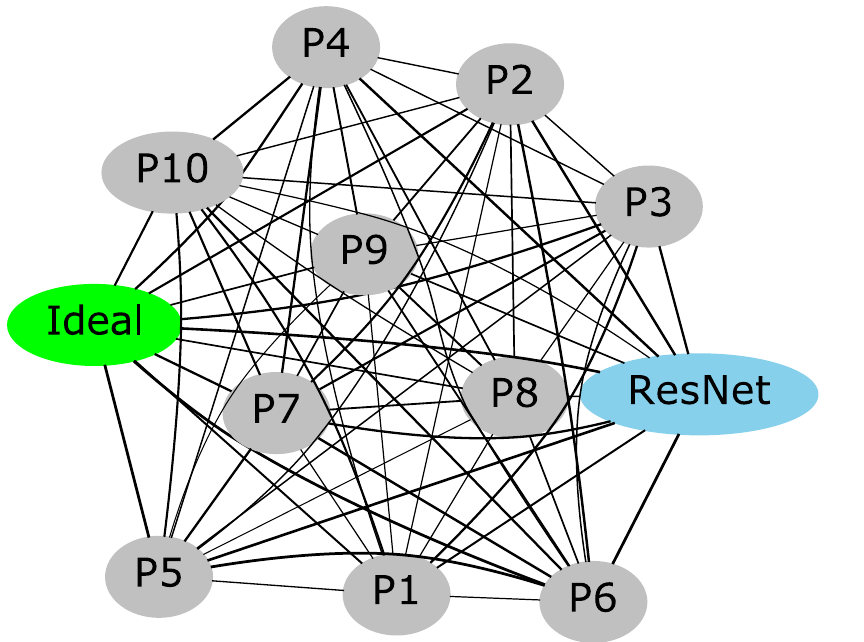
Fig 4. Graphical representation of the Hamming loss between the decisions of human participants (grey nodes), ResNet (light blue node) and ideal decision maker (green node). The weight of each edge is inversely proportional to the Hamming loss between the two nodes connected by that edge, hence representing how similar were the decisions made by the two nodes.